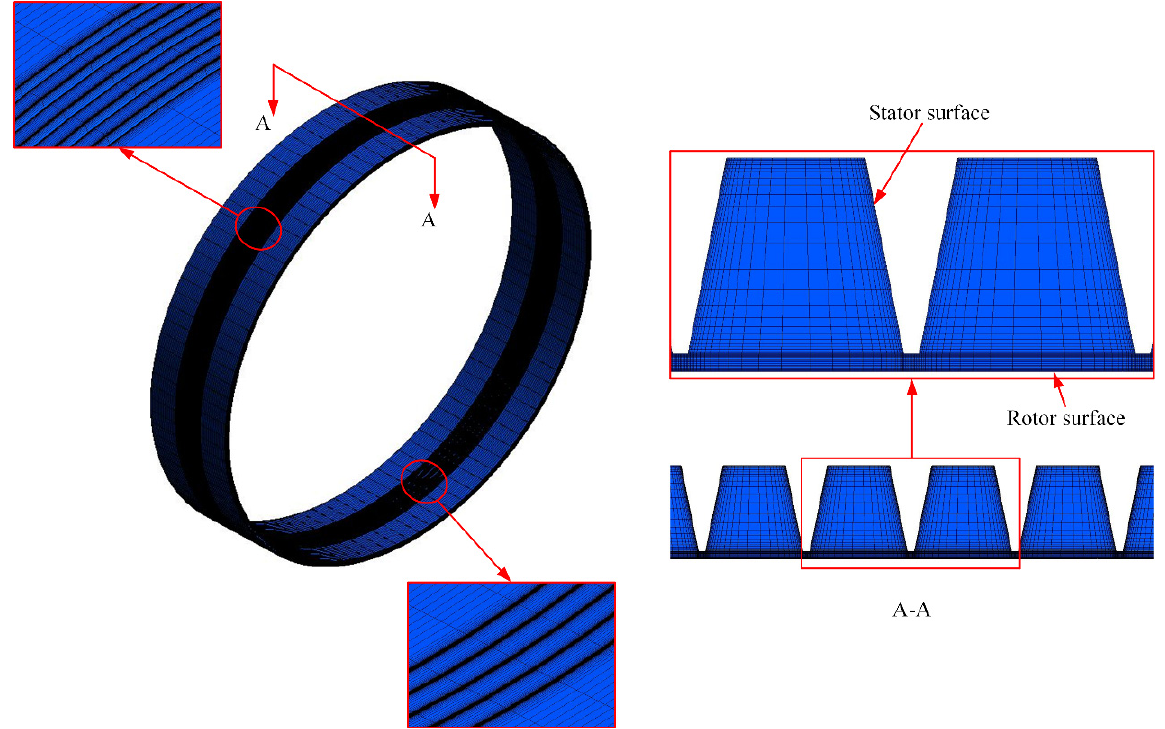
Figure 10. Computational mesh of labyrinth seal.